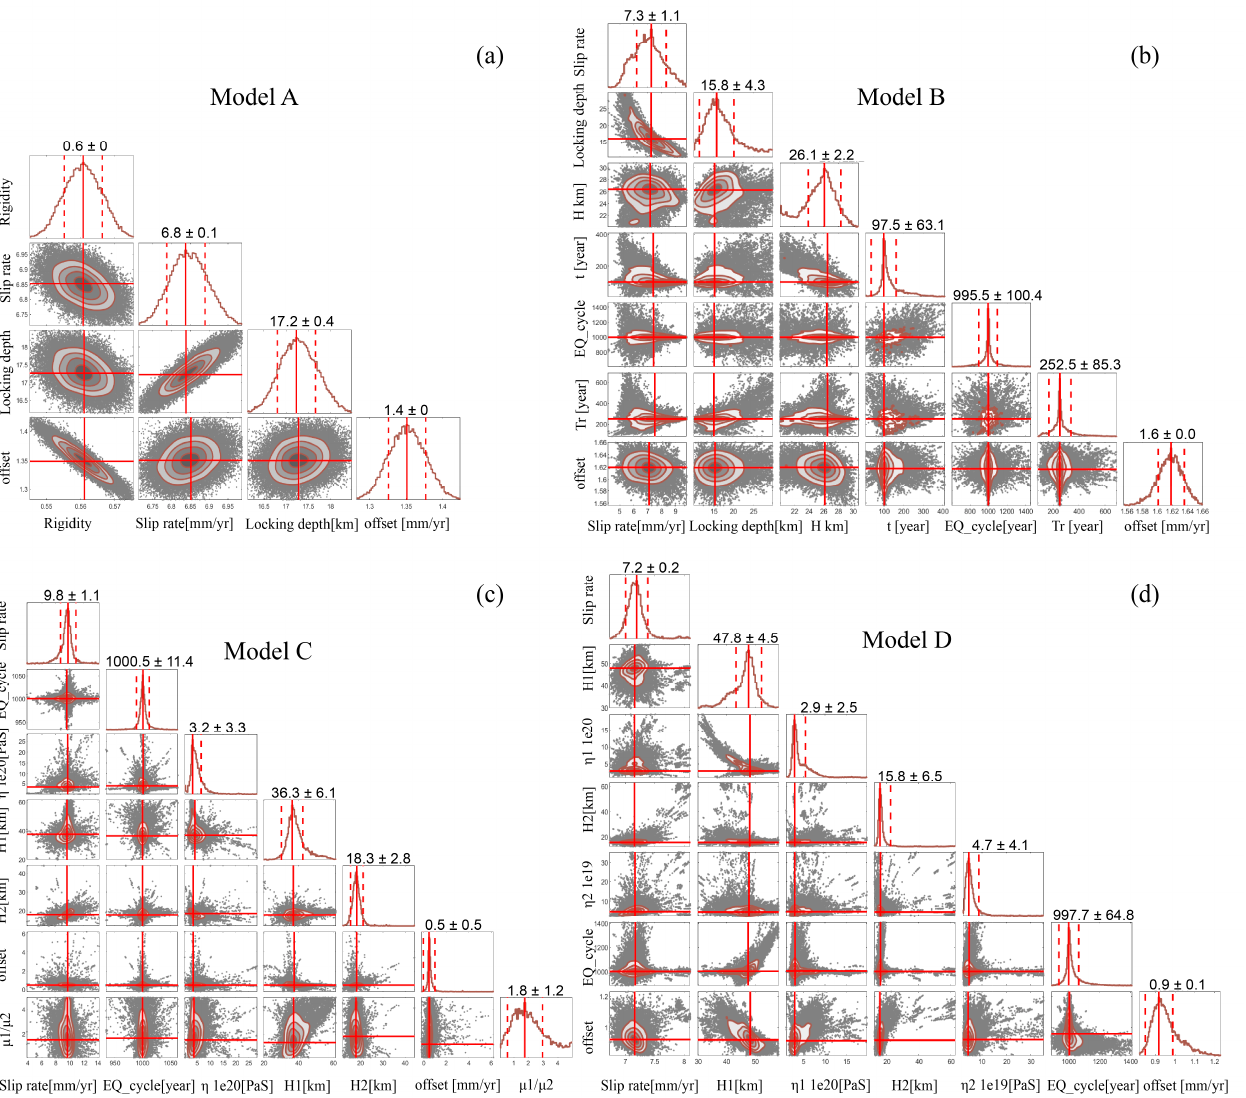
Figure 7. Inversion results of profile MN using the MCMC method. Results of ( a ) Model A, ( b ) Model B, ( c ) Model C, ( d ) Model D.